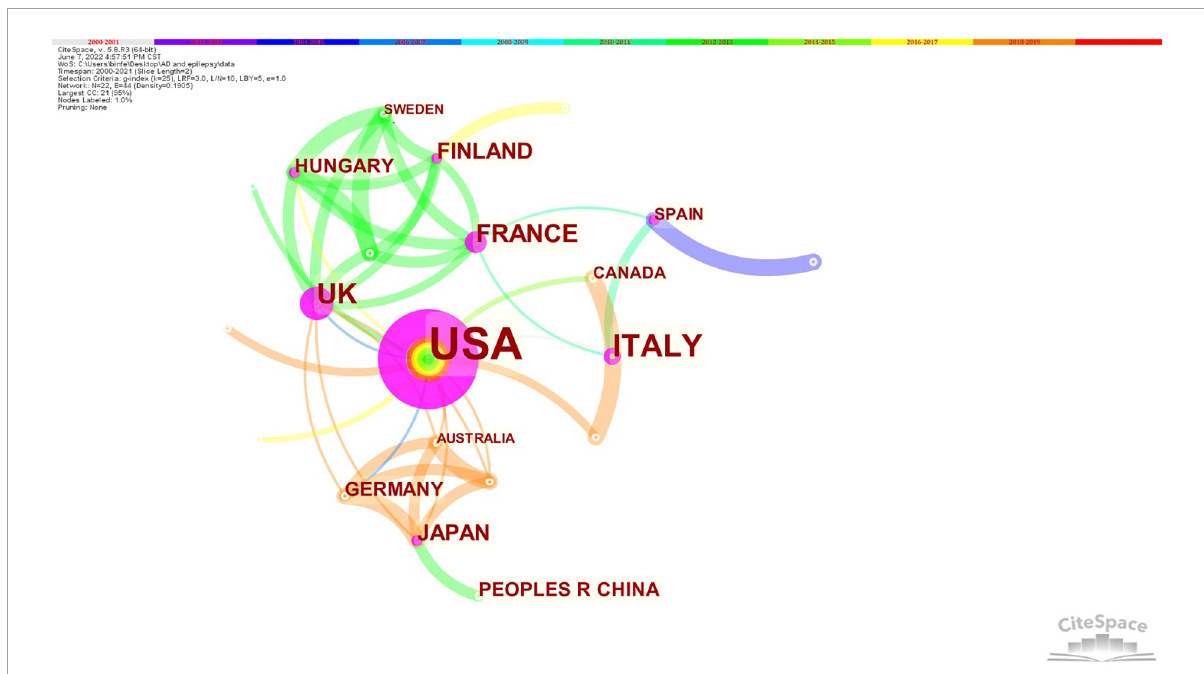
FIGURE4 Contributions of countries. Purple rings indicated that these countries/regions had greater centrality (no less than 0.1). The size of the circle represents the number of papers published by the country. The shorter the distance between two circles, the greater the cooperation between the two countries. United States was the most influential research